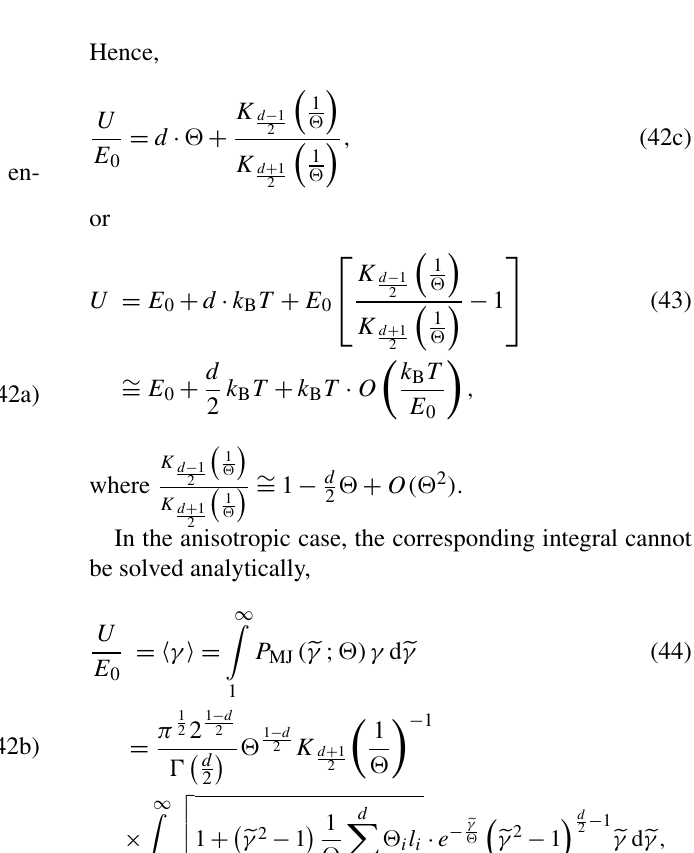
q θ 2 i = 1 , θ i ≡ 2 k B T i . MB is the Maxwell–Boltzmann m E 0 2 c 2